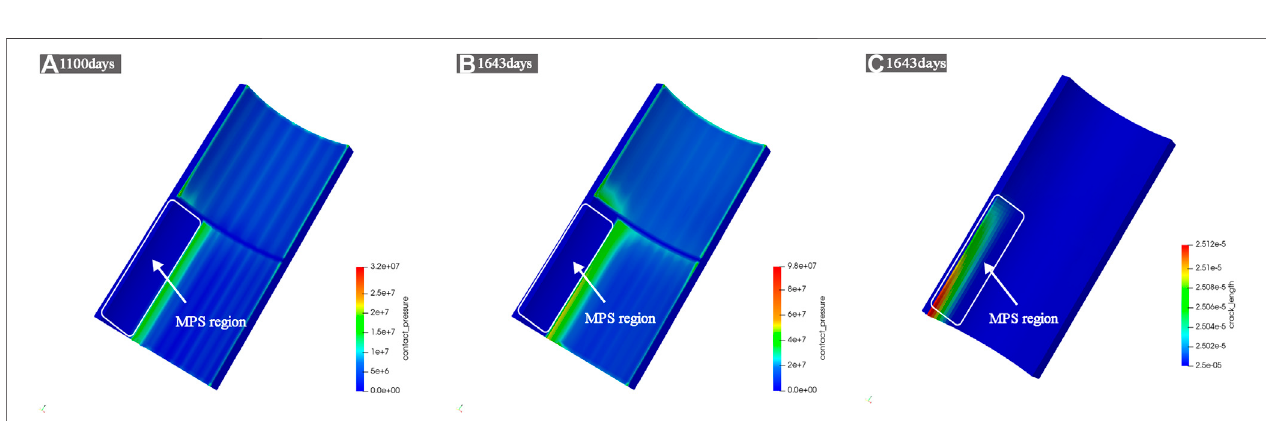
FIGURE 16 | Contact pressure distribution in 1100 days (A) , in 1643 days (B) and crack length distribution in 1643 days (C) .